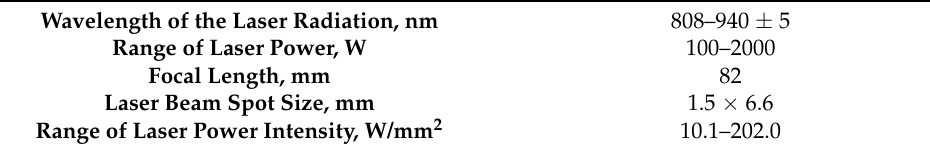
Figure 1. The ductile cast iron EN-GJS-350-22 microstructure (optical microscope). Table 2. Technical specifications of the Rofin Sinar DL020 HPDDL.